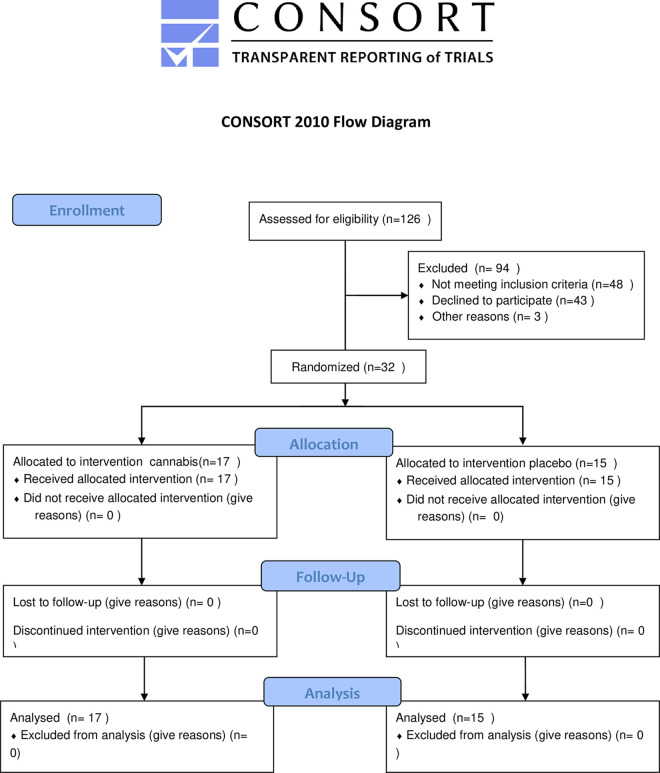
CONSORT 2010 flow diagram.